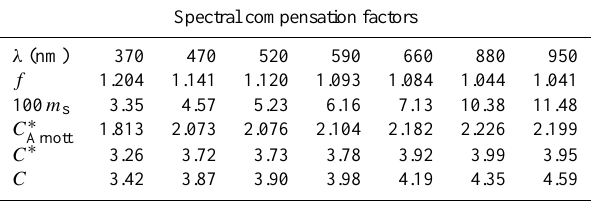
Table 1. Compensation factors obtained for the seven Aethalometer wavelengths: f corresponds to the “shadowing effect” in the load- ing compensation; 100 m s is the value given in Arnott et al. (2005) to the scattering fraction of particles; C ∗ is the value given in Arnott Arnott et al. (2005) to the multiple-scattering compensation factor ( C ∗ in Schmid et al., 2006, and in this work); C ∗ and C are the values specifically site-calculated in this